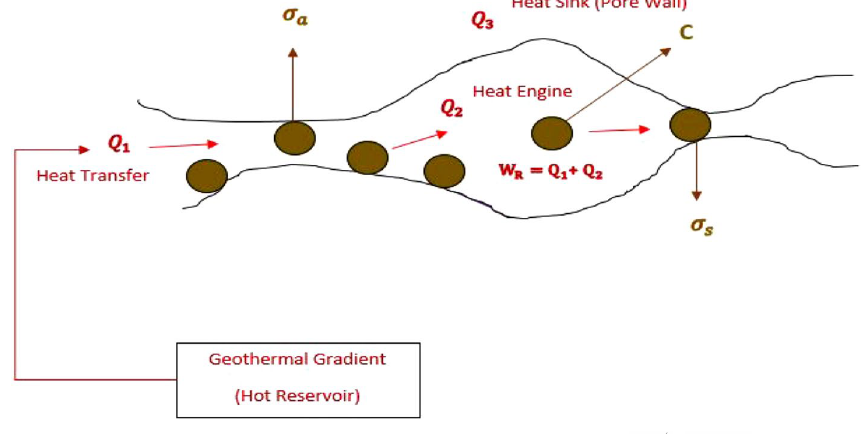
Fig. 3 Schematic diagram of strained and detached fines due to the influence of geothermal